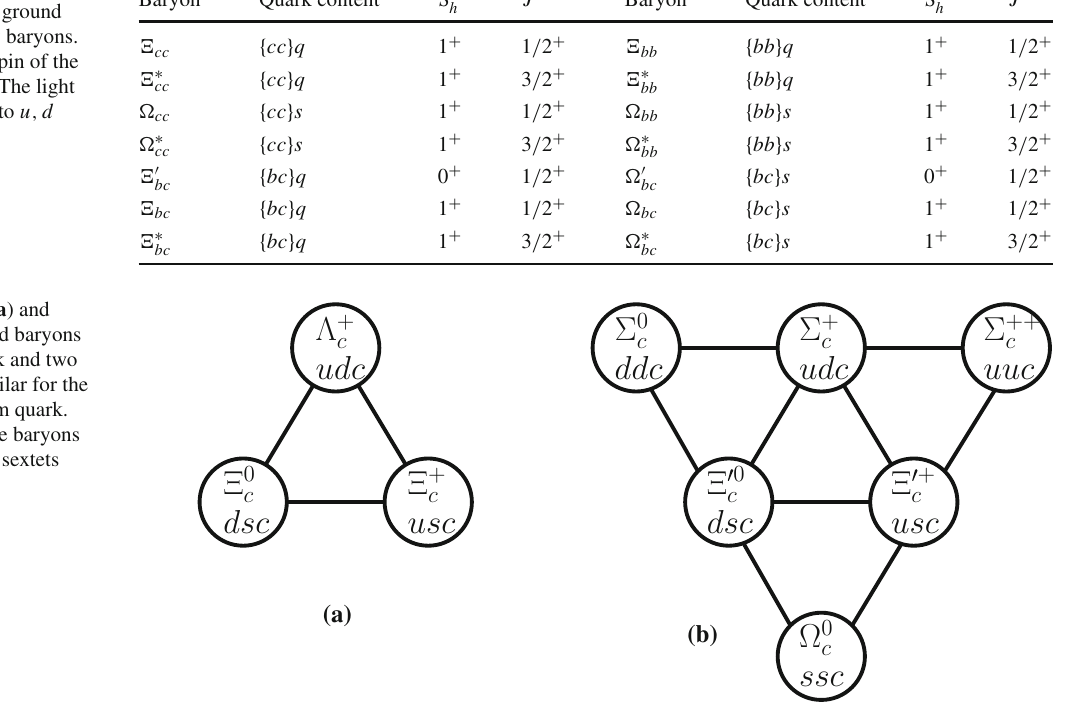
quark content for the ground state of doubly heavy baryons. The S π denotes the spin of the h heavy quark system. The light quark q corresponds to u , d